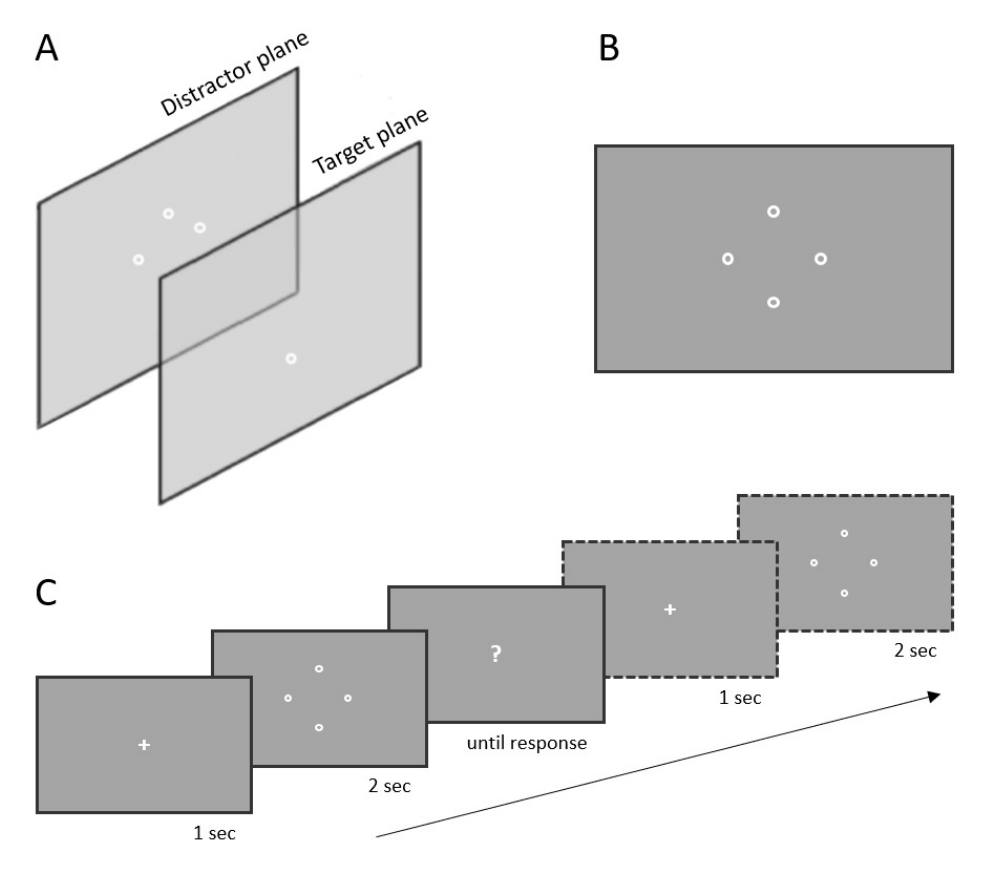
Figure 1. (A) Side view and (B) front view of the item layout. The target was displayed one plane closer to the viewer (Target plane) compared to distractors (Distractor plane) within the optical element of the multi- plane display. (C) The visual task sequence. The fixation cross appeared for one second at the beginning of each trial. Then four circles were shown on the screen. The trial finished with the submission of the subject’s response when the question mark was shown. The illustrations are not to